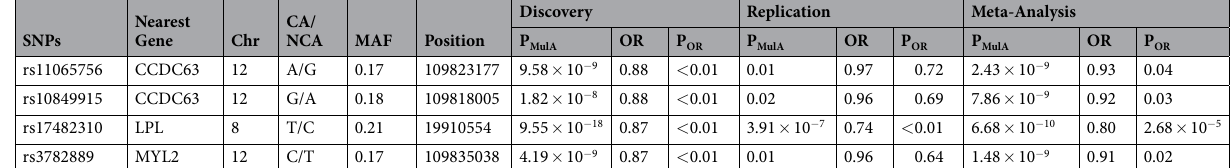
Table 1. Novel common SNPs 1) for metabolic syndrome achieving genome-wide significance in Korean population. 1) SNPs not previously reported in GWAS of any other MetS traits. Chr, chromosome; MAF, minor allele frequency; OR, odds ratio; P MulA , P for multivariate